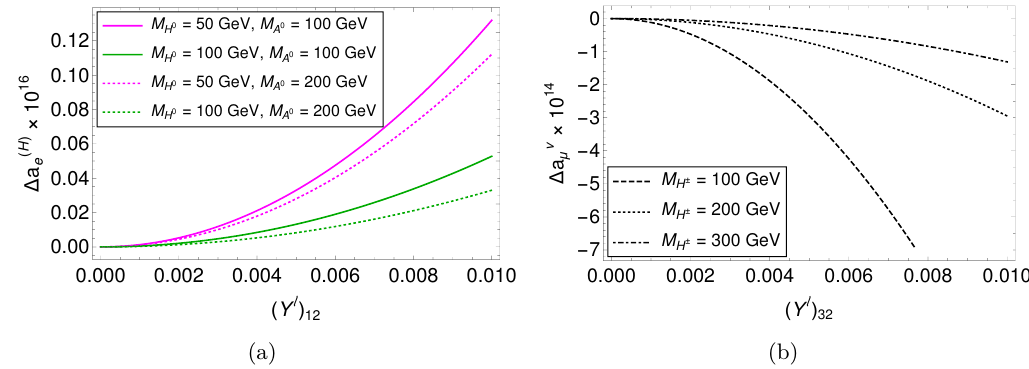
Figure 22 . (a) Variation of ∆a ( H ) e with the relevant Yukawa coupling Y ‘ M and M . (b) Dependencies of ∆ a ν H 0 A 0